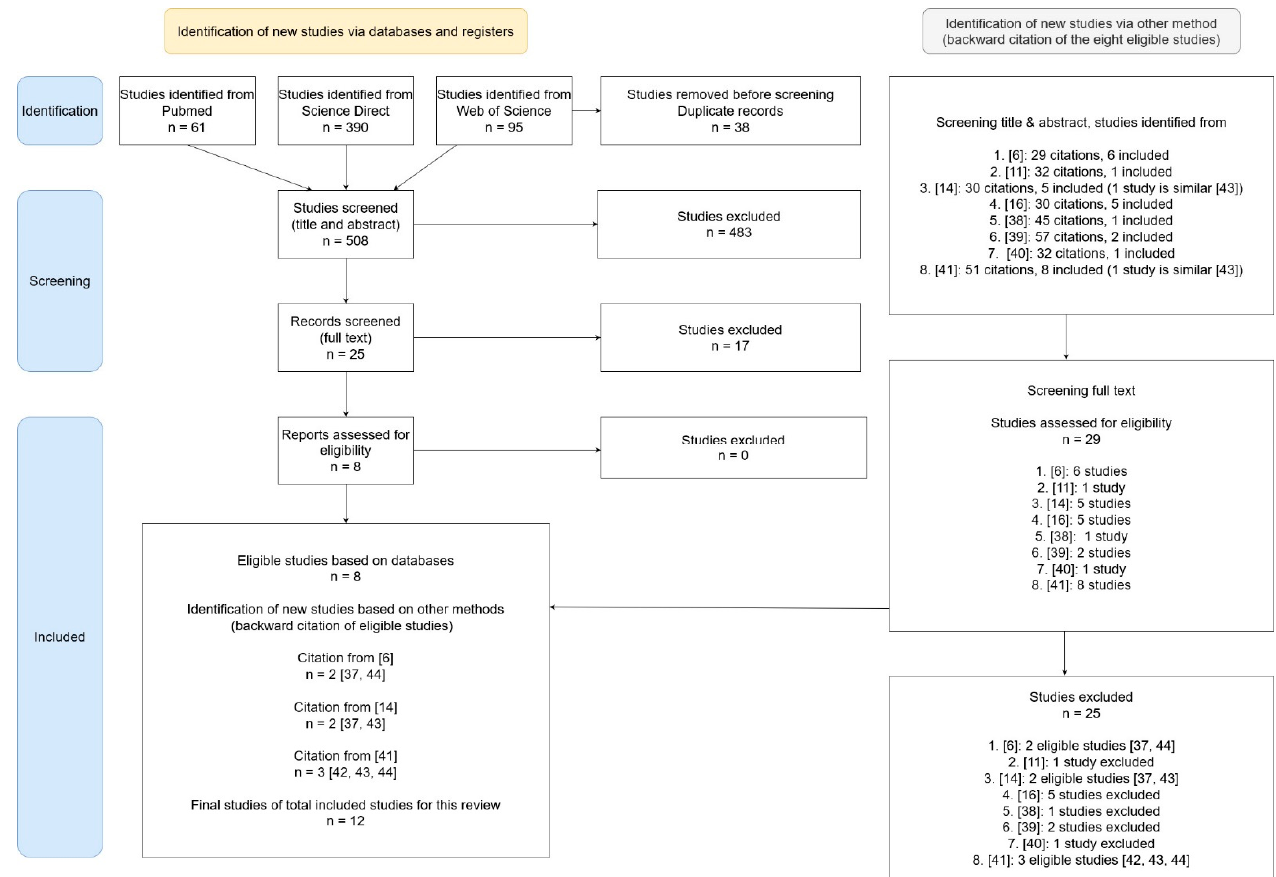
Figure 1. PRISMA 2020 flowchart for the literature screening process of the study [6,11,14,16,37–44].